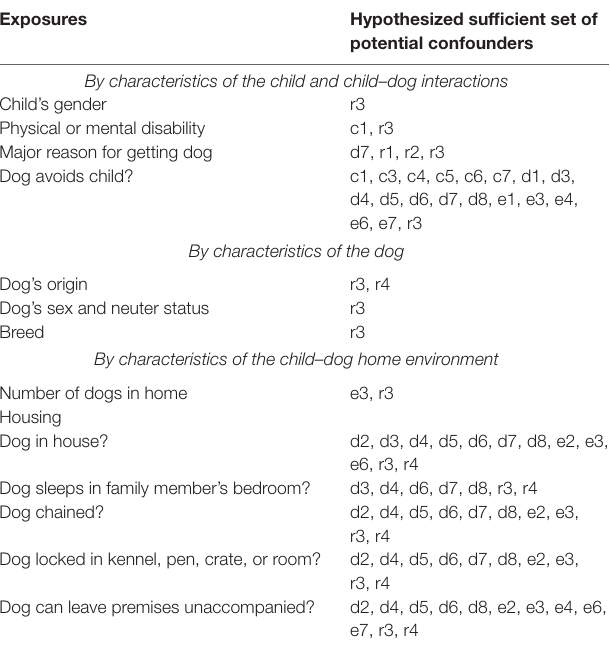
TaBle 1 | Variables included in each hypothesized minimally sufficient set of confounders during the regression procedure analyzing risk factors for bites to a child from the family